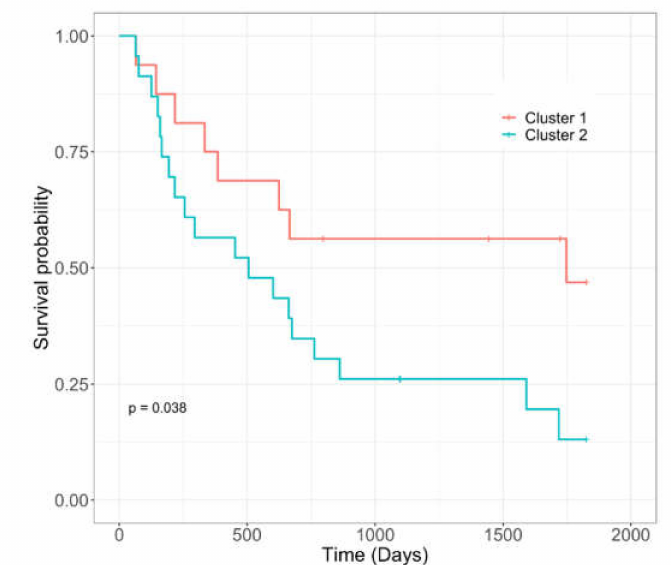
Figure 4. Survival analysis of HNSCC subtypes resulting from hierarchical clustering of HERV expression in tumor-adjacent normal tissue (Supplementary Figure S4). Vertical lines indicate censored data. Curves were fit using the Kaplan–Meier model and statistical significance was calculated using the log-rank